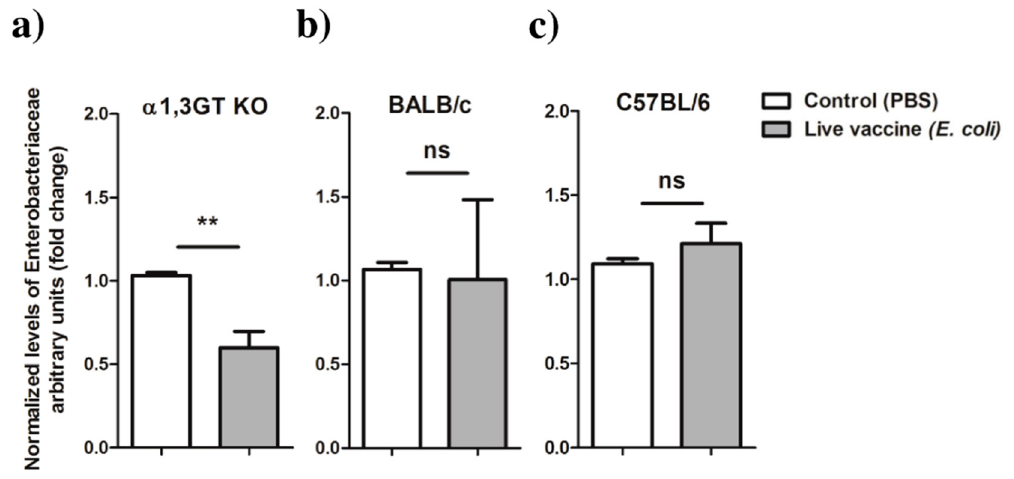
Figure 7. Relative abundance of Enterobacteriaceae in I. ricinus microbiota after feeding on E. coli -immunized mice. The relative abundance of Enterobacteriaceae was measured in adult ticks that in the previous stage (i.e., nymphs) had fed on ( a ) α 1,3GT KO or ( b ) BALB / c and in engorged nymphs that fed on ( c ) C57BL / 6 mice. Relative bacterial DNA levels were measured using Enterobacteriaceae-specific 16S qPCR normalizing against tick rsp4 with the 2 − ∆∆ Ct ratio method. Results are relative to 16S in the control group. Means and standard deviation values are displayed. Results were compared within each mouse strain by Mann − Whitney U test. (** p < 0.001, ns—not significant; n = 11 pools of ticks that fed α 1,3GT KO mice, n = 9 pools of ticks that fed BALB / c, n = 18 pools of ticks that fed C57BL / 6